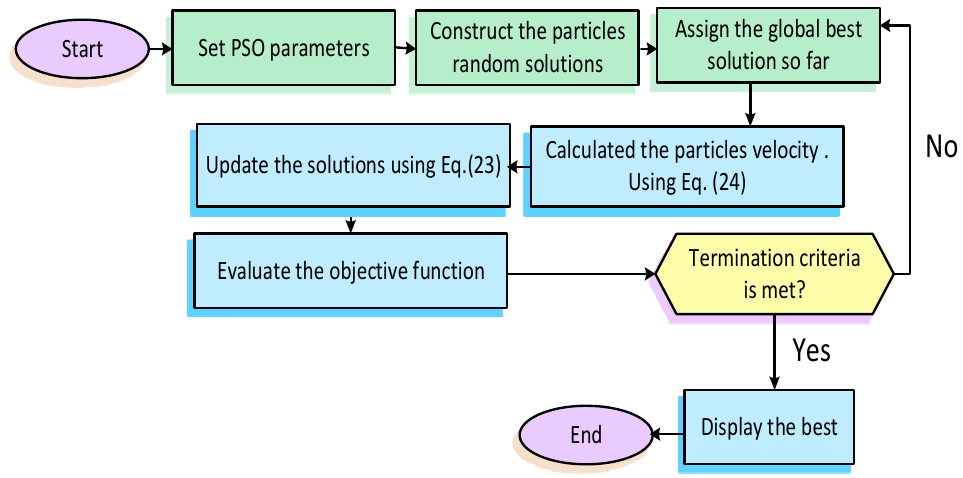
Figure 2. Flow diagram of the Particle Swarm Optimizer (PSO) algorithm.